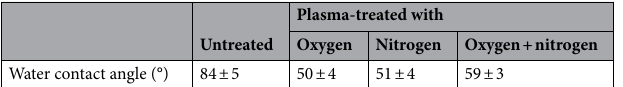
Table 2. Water contact angle of variously pretreated polyamide fabrics.